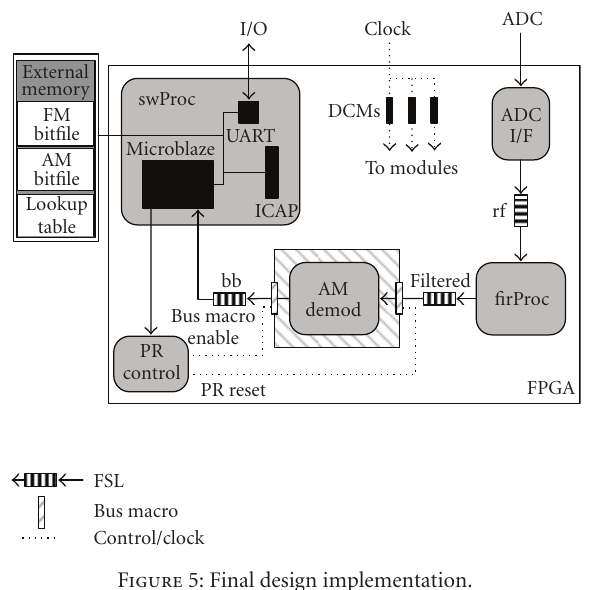
Figure 5: Final design